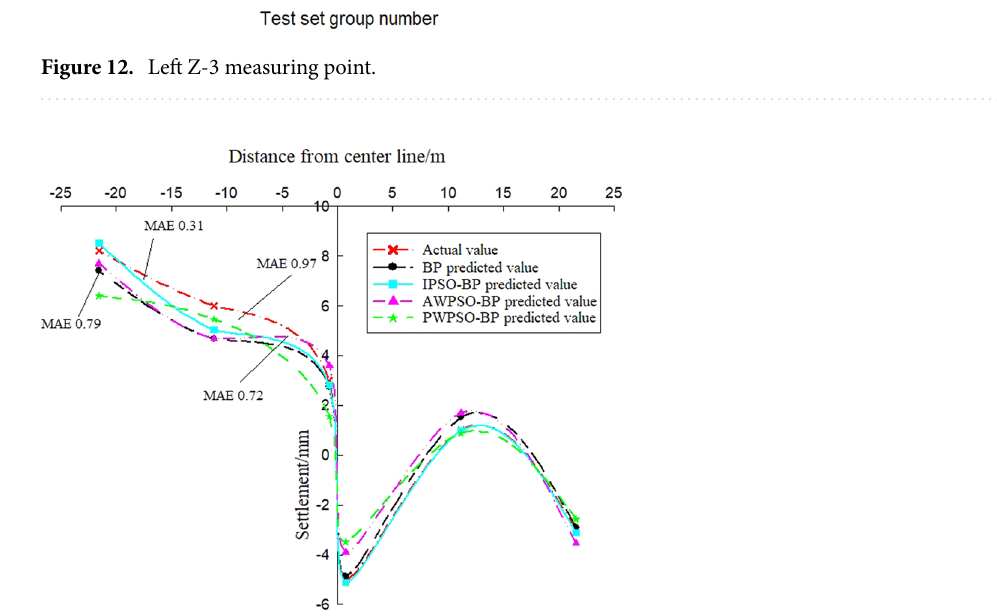
Figure 13. Longitudinal measuring points on the